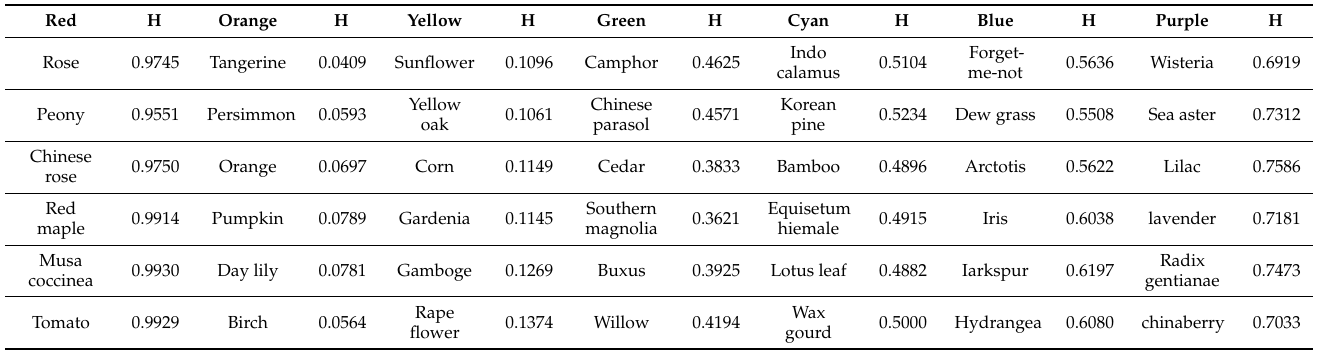
Table 2. H-tone component values of seven coloured